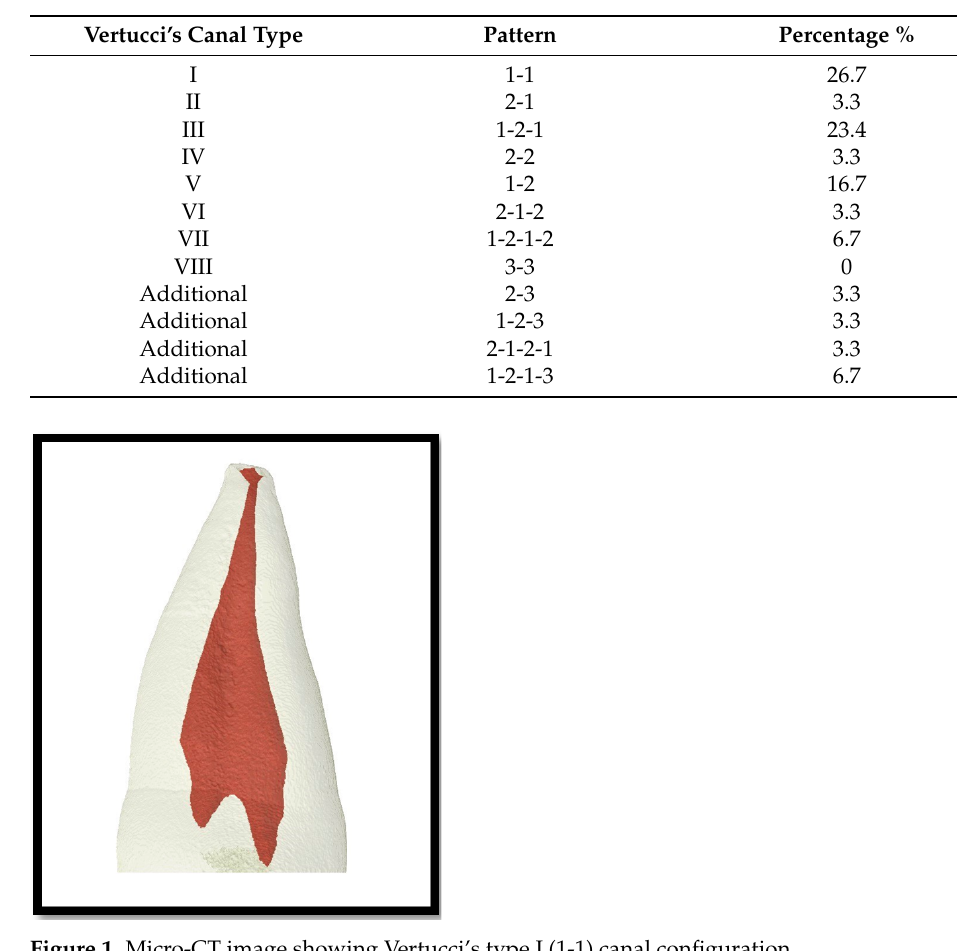
Table 1. Distribution of the canal configuration of MSPs observed in the study.